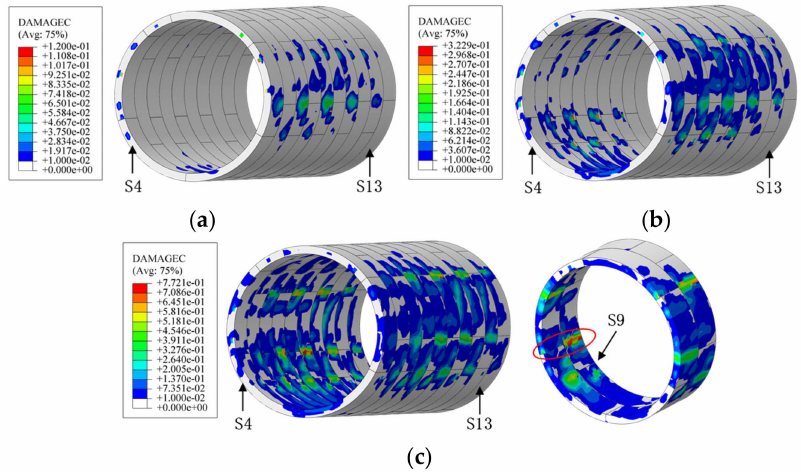
Figure 12. Compressive damage distribution of shield tunnel under reverse faulting: ( a ) under 10 cm fault displacement, ( b ) under 15 cm fault displacement, ( c ) under 20 cm fault displacement. Some like +1.200e-01 means 1.2 × 10 − 1